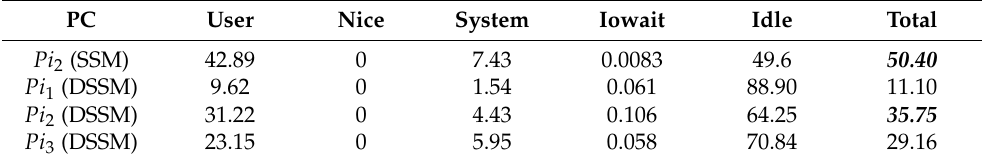
Table 8. Details of CPU usage in Ex 1.